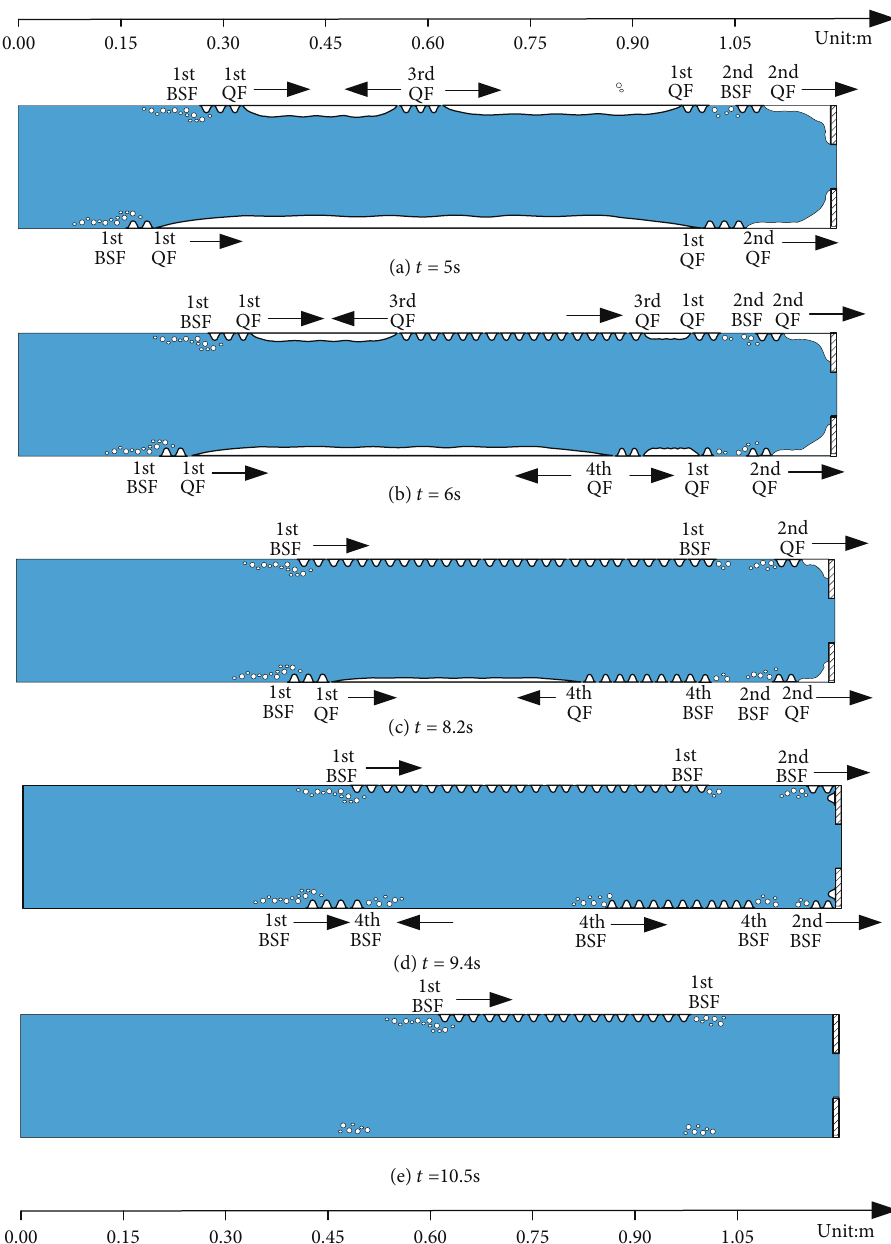
Figure 6: Flow patterns in the experimental section during the chill-down process for Exp.